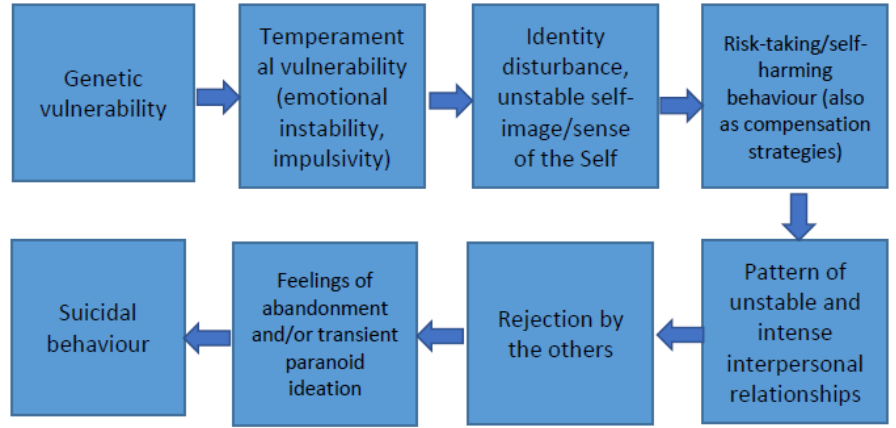
Figure 1. Drafting arrows. A biological–psychological interface model for borderline pd.